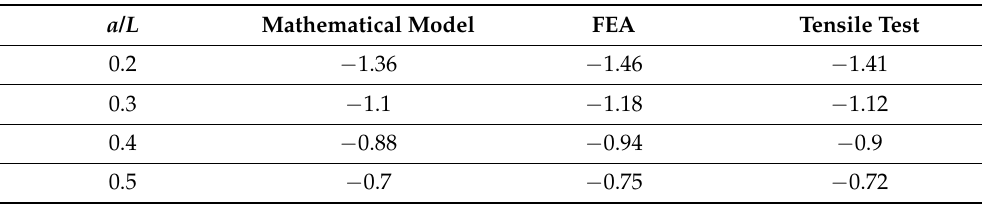
Table 3. Poisson’s ratio obtained from the mathematical model, FEA, and tensile testing for loading in the